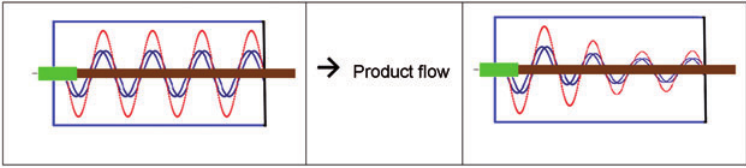
Figure 3 Left: Reaction tube centered in the monomode resonator microwave fi eld without medium. Right: Exponential decay of fi eld strength along the reaction tube in presence of reaction medium with dielectric